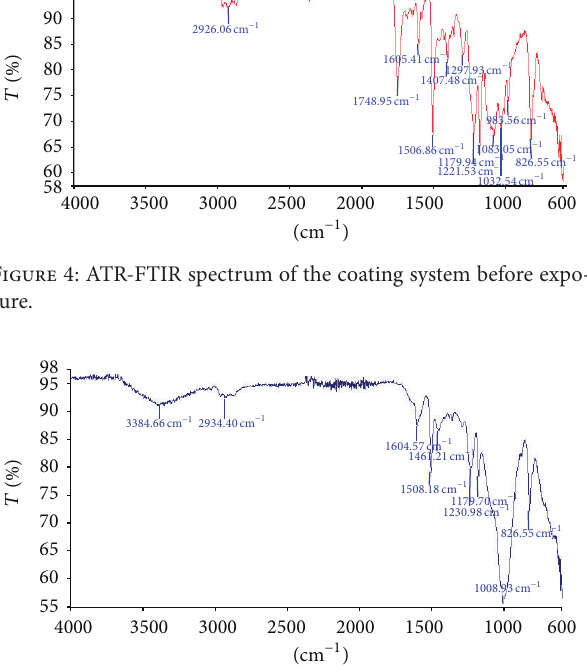
Figure 5: ATR-FTIR spectrum of the discolored zone of the coating system after